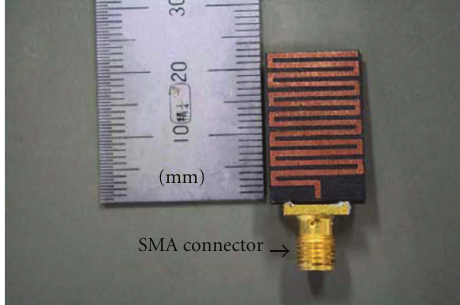
Figure 11: Photograph of the 3L-CFMA.